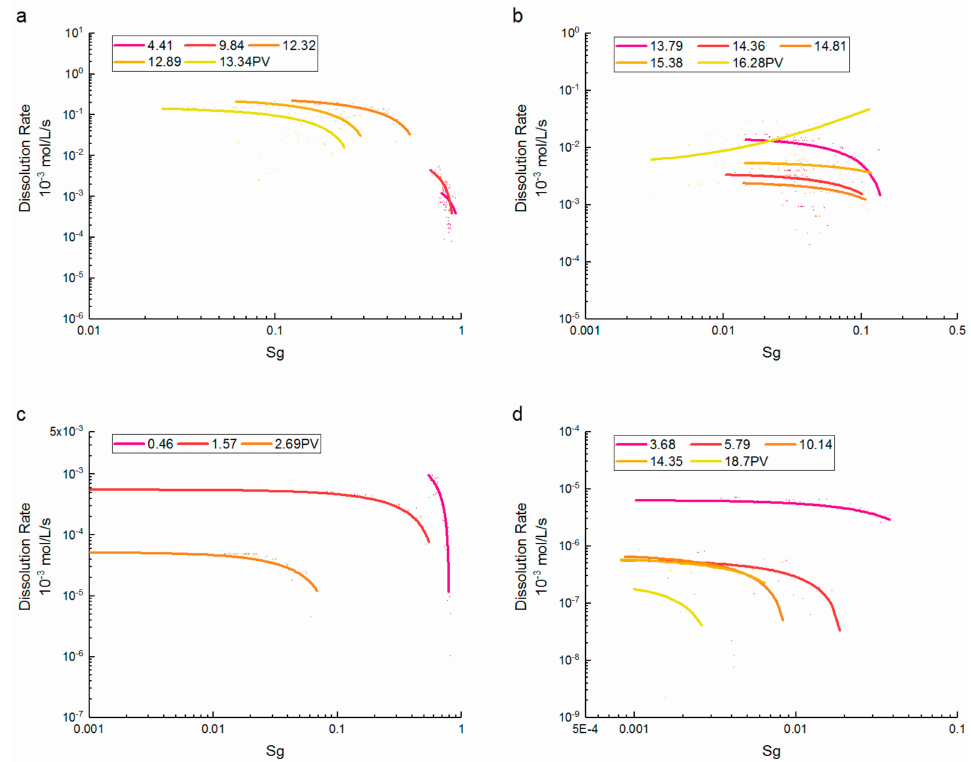
Figure 5. CO 2 dissolution rate vs. CO 2 saturation at different injection PVs for ( a , b ) supercritical CO 2 and ( c , d )gaseous CO 2